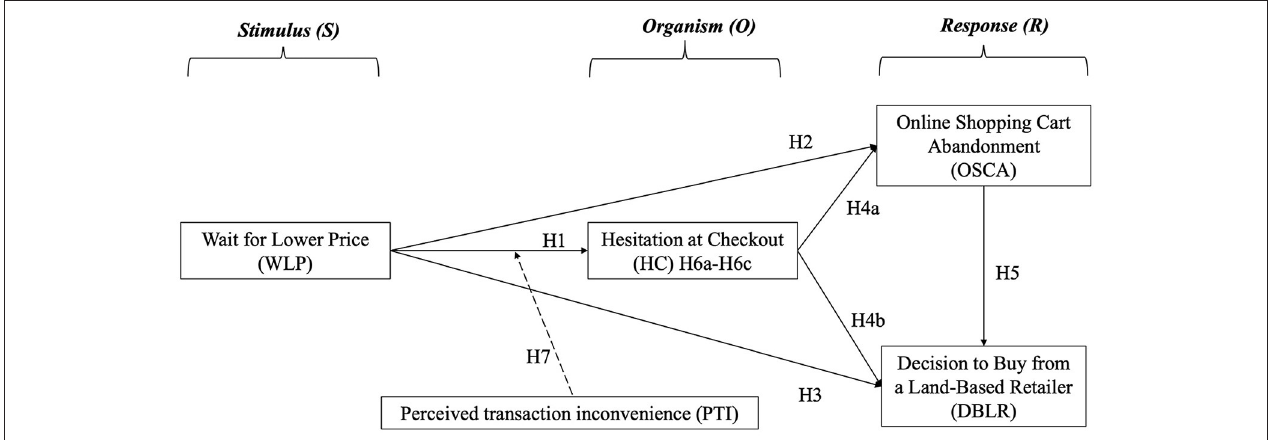
FIGURE 1 | Research